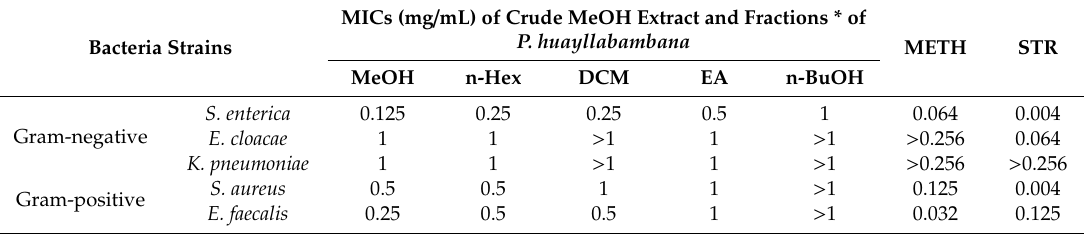
Table 2. Minimal inhibitory concentrations (MICs) of the crude methanolic extract and subsequent partition fractions from P. huayllabambana fruits against studied bacterial